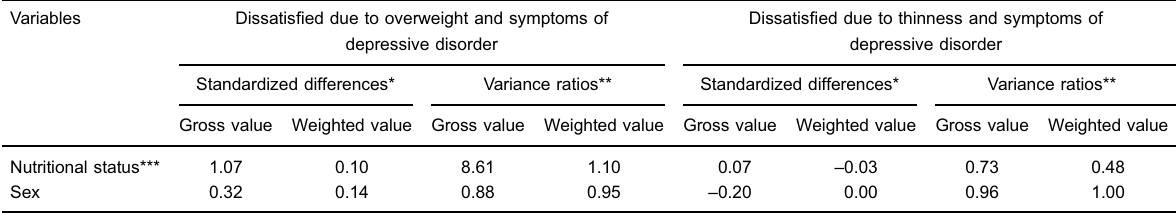
Table 1. Balancing of the variables by weighting with sample propensity score.